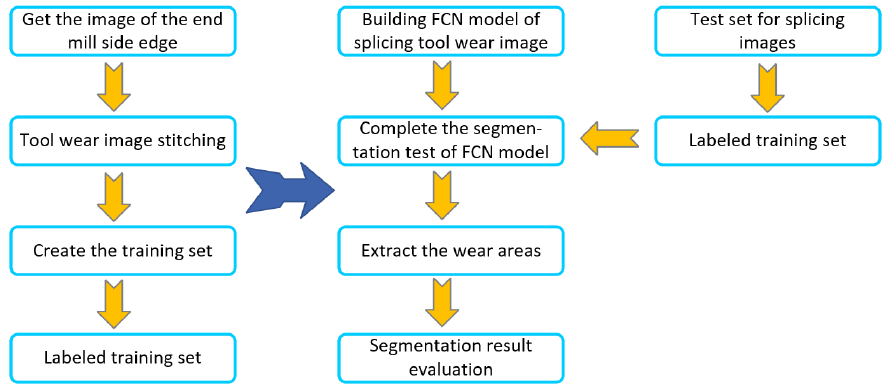
Figure 10. Flowchart of hologram segmentation algorithm of end mill side edge.